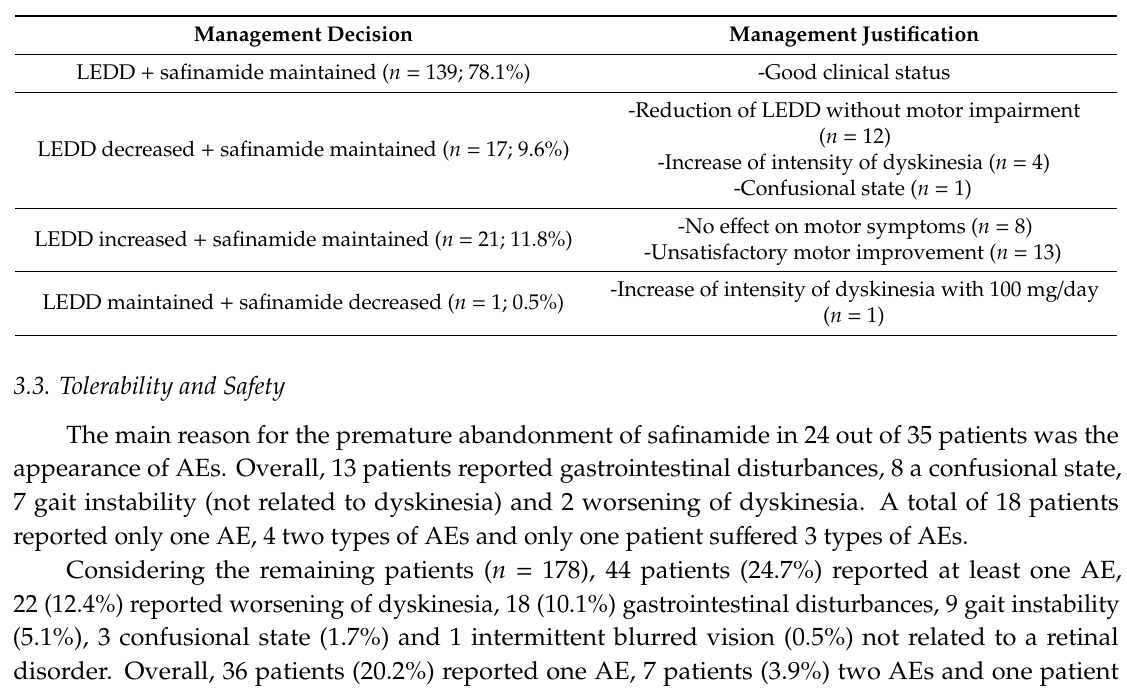
Table 4. Management decisions after follow-up